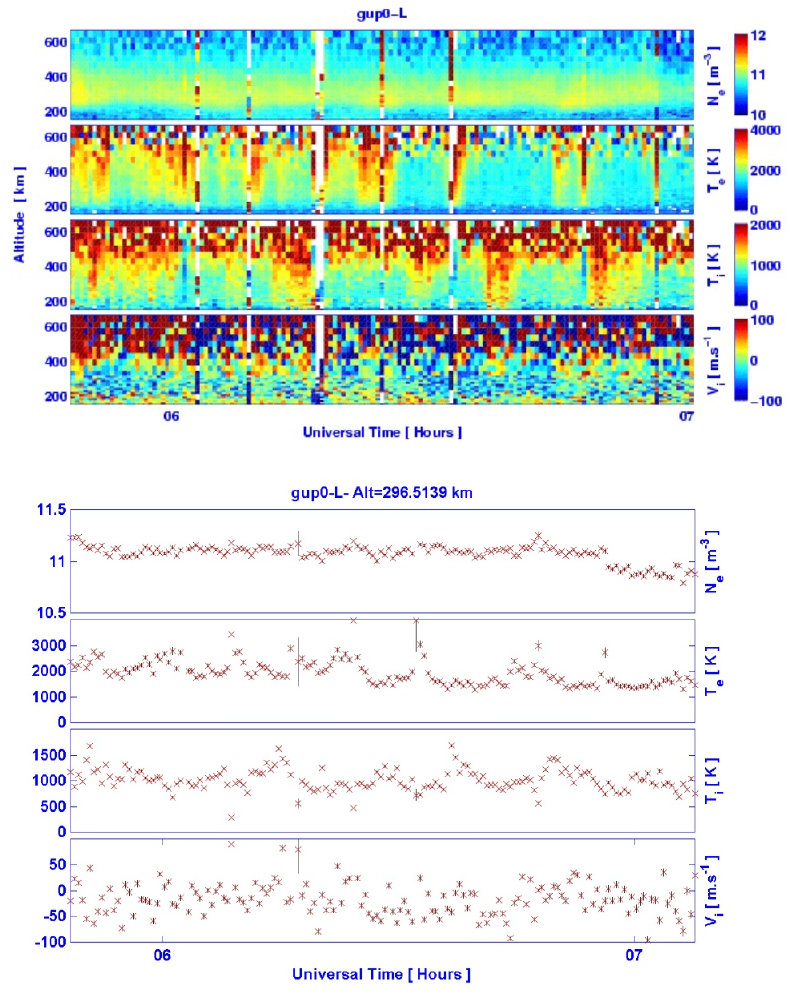
Fig. 5. Ionospheric plasma parame- ters measured by the ESR (dish point- ing field-aligned). Upper panel, from top to bottom: N e , electron density, T e , electron temperature, T i , ion tempera- ture, and line-of-sight velocity, V i (pos- itive away from the radar) as a function of time and altitude. Lower panel: time series of the same parameters measured at 300km of